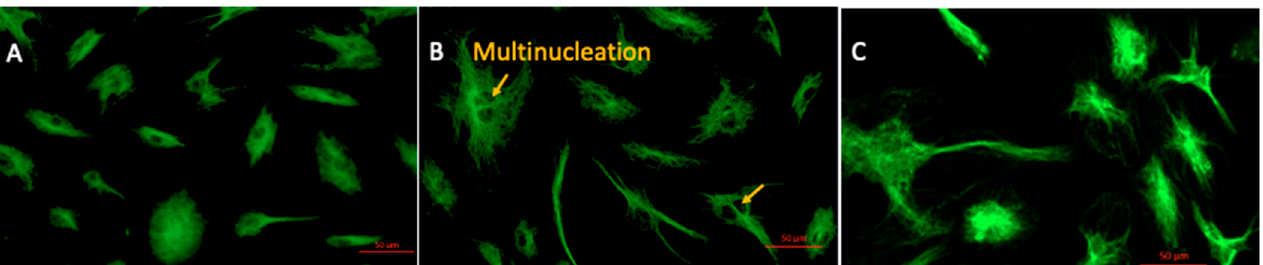
Figure 2. Changes in the cytoskeletal protein, alpha-tubulin in response to incubation of HAEC with SAA, with and without added 4-MetT. Representative images correspond to ( A ) Control ( B ) 10 µg/mL SAA ( C )10 µg/mL SAA + 25 µM 4-MetT pre-incubation. Data shown are representative of ( n = 3 control, n = 5 SAA, SAA + 4-MetT) independent studies.